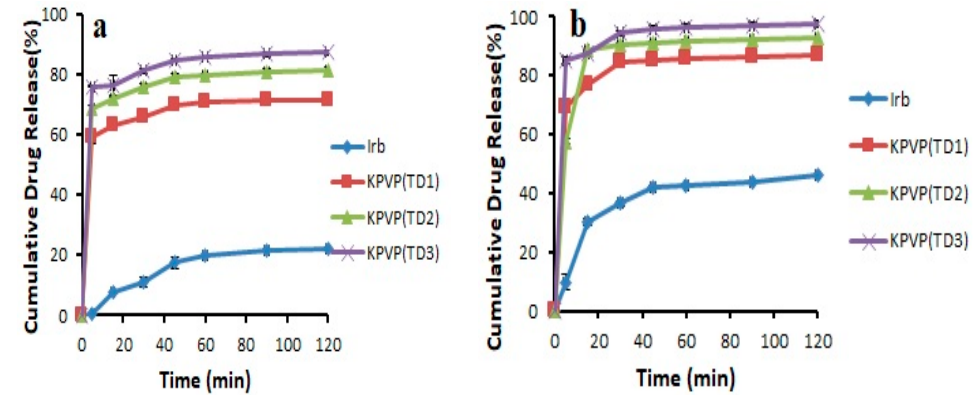
Figure 7. Dissolution profile of pure Irbesartan and ternary solid dispersions formulated with PVP- K30 in ( a ) pH 6.8 phosphate buffer ( b ) 0.1 N HCl (n = 3, mean ± SD).